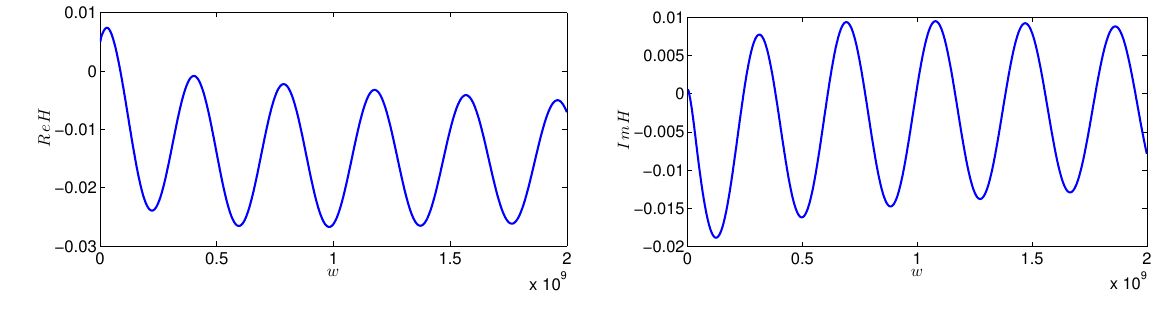
Figure 15. Re H and Im H in the stripline example with N = 1000